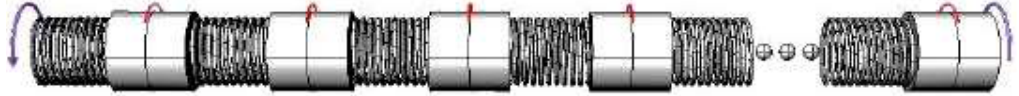
Figure 14. Representation of the propulsion shaft as a discretized cascaded 1D interconnection of inertial mass and spring elements.